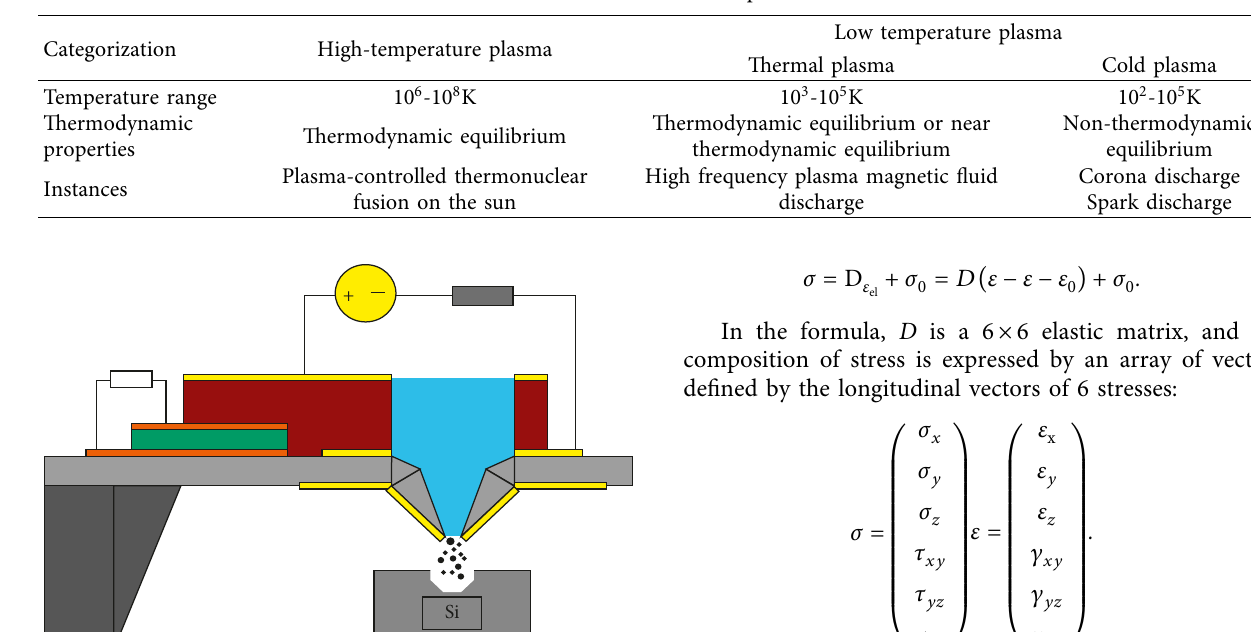
Table 1: Classification of